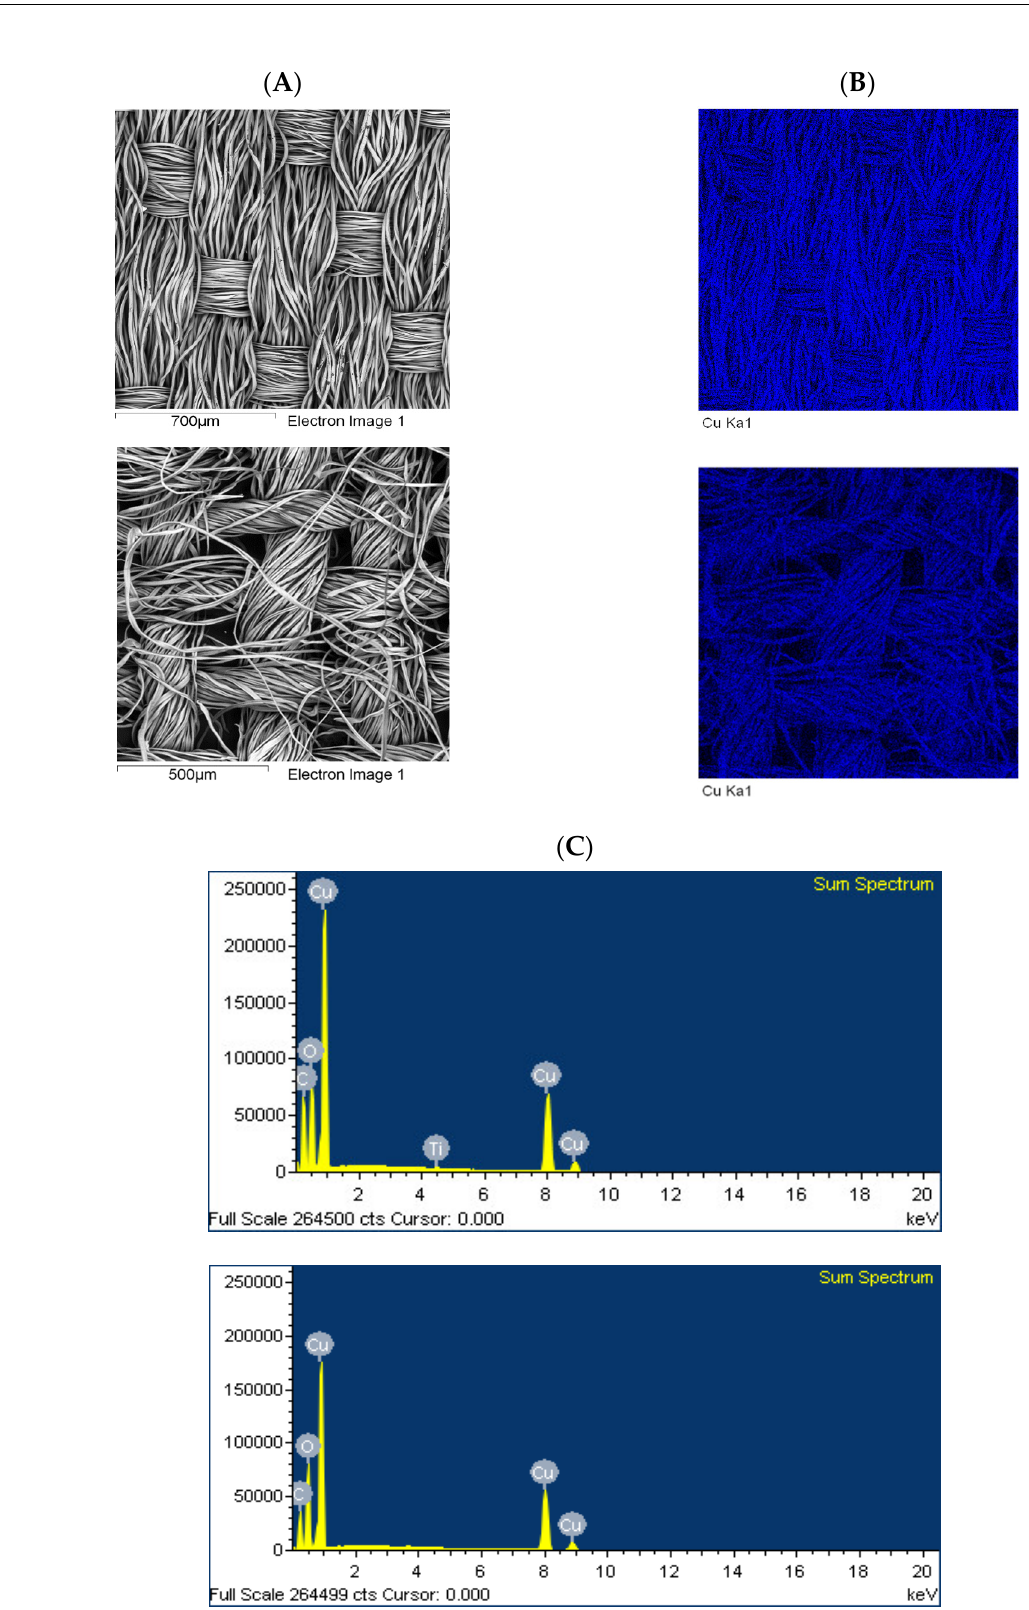
Figure 4. Results of SEM/EDS analysis: SEM images ( A ), exemplary maps of Cu distribution (blue) ( B ) and sum spectra ( C ).